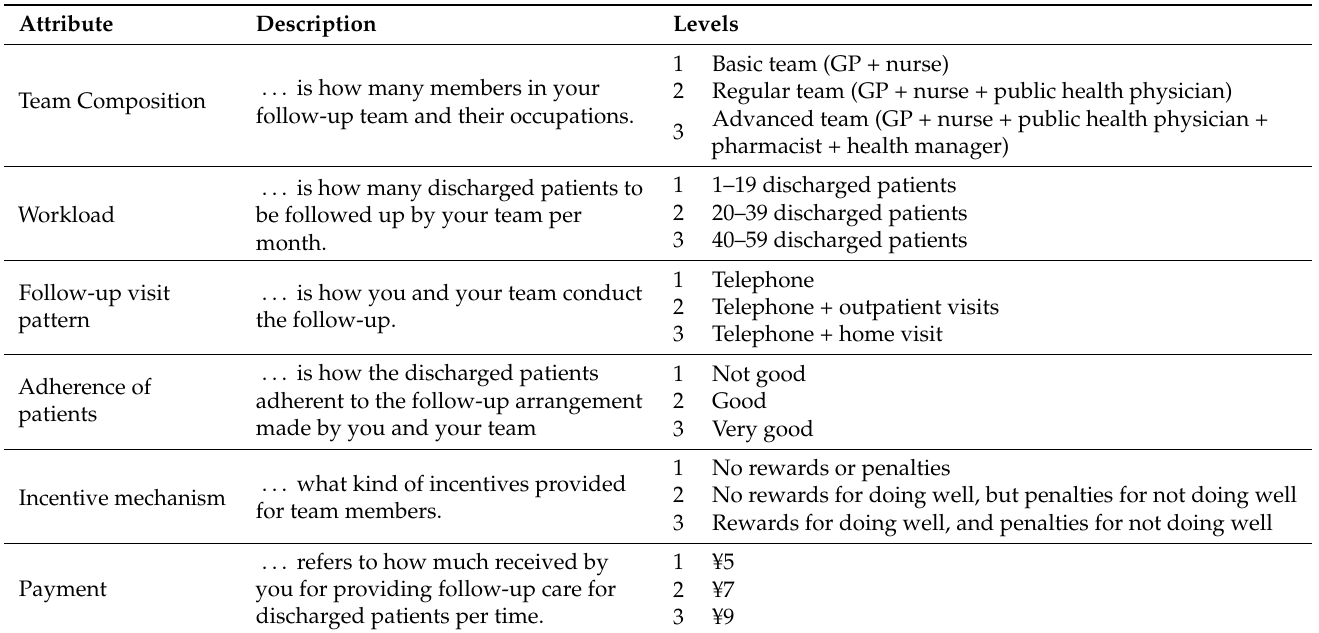
Table 1. Attributes and levels adopted in the discrete choice